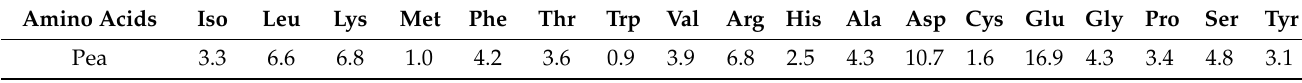
Table A1. Amino-acid composition of pea protein, g of amino acid/100 g of protein [44]. Amino